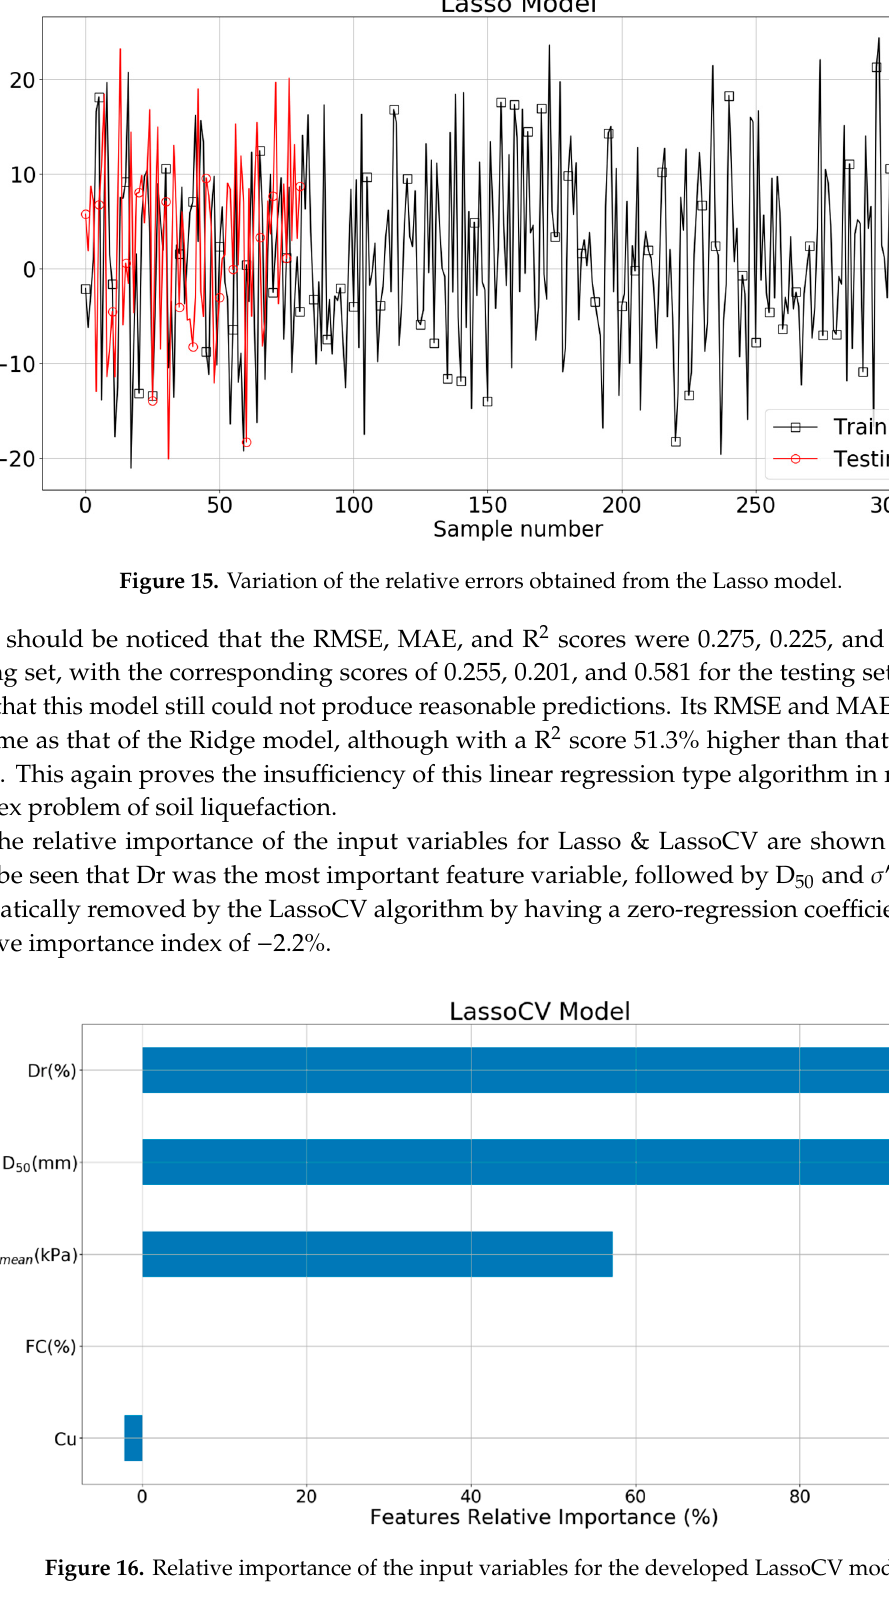
Figure 14. Comparison between the target and Lasso model predicted Log(W).